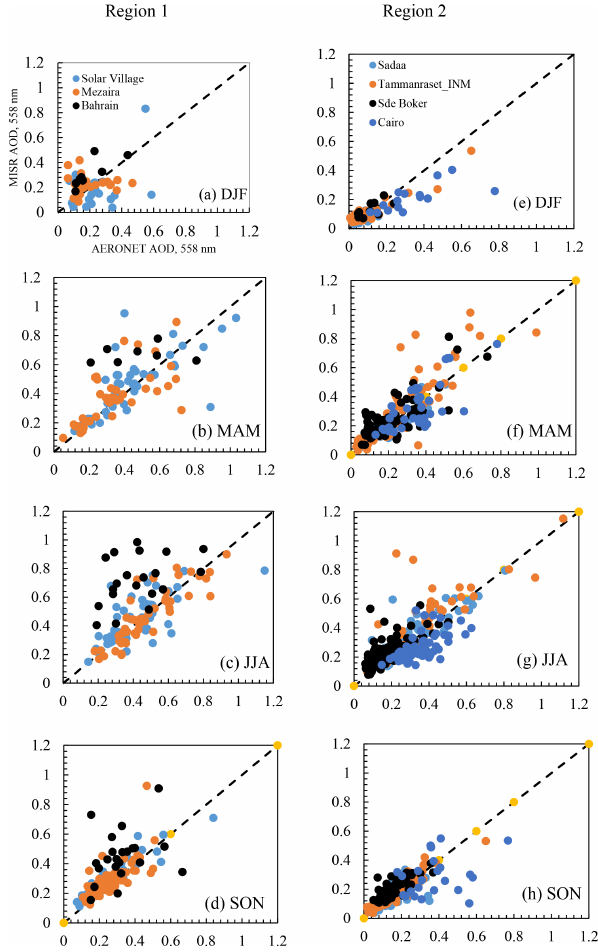
Figure 2. Scatter plot of MISR AOD versus AERONET AOD based on seasons and aerosols